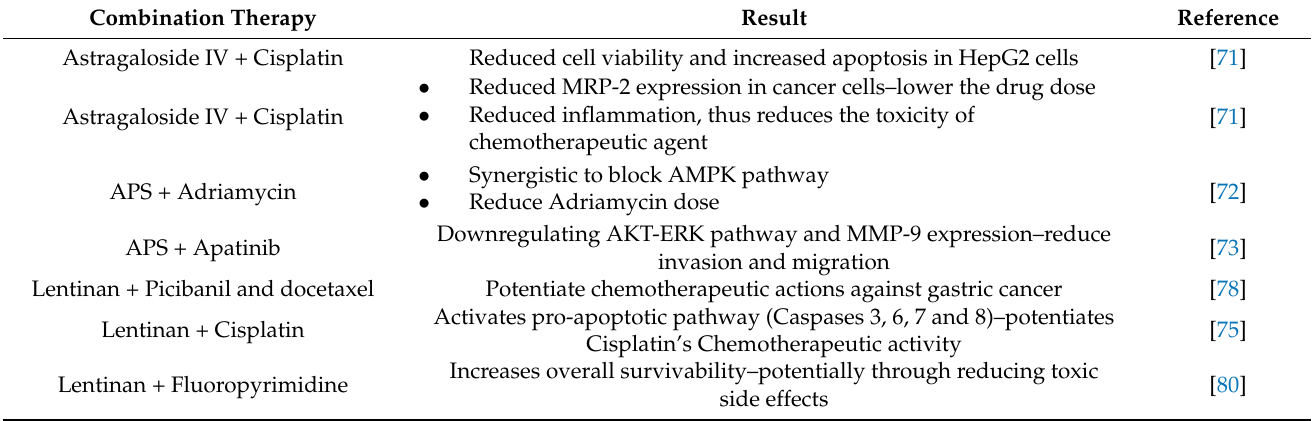
Table 1. Adjuvant activity of Shiitake/ Astragalus extracts in combination with standard chemotherapeutic agents against cancer. Combination Therapy